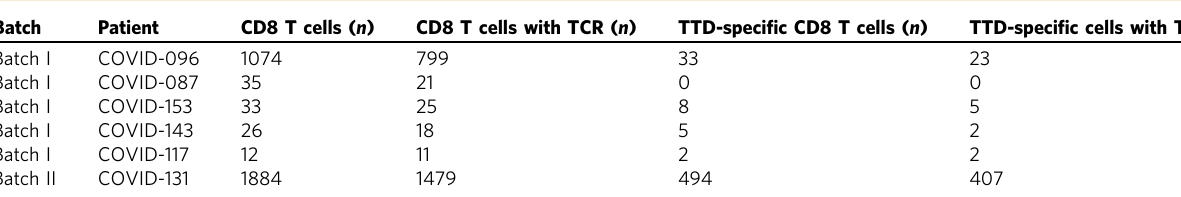
Table 2 Number of CD8 T cells and TTD-speci fi c CD8 T cells obtained from single-cell RNA-sequencing per patient.